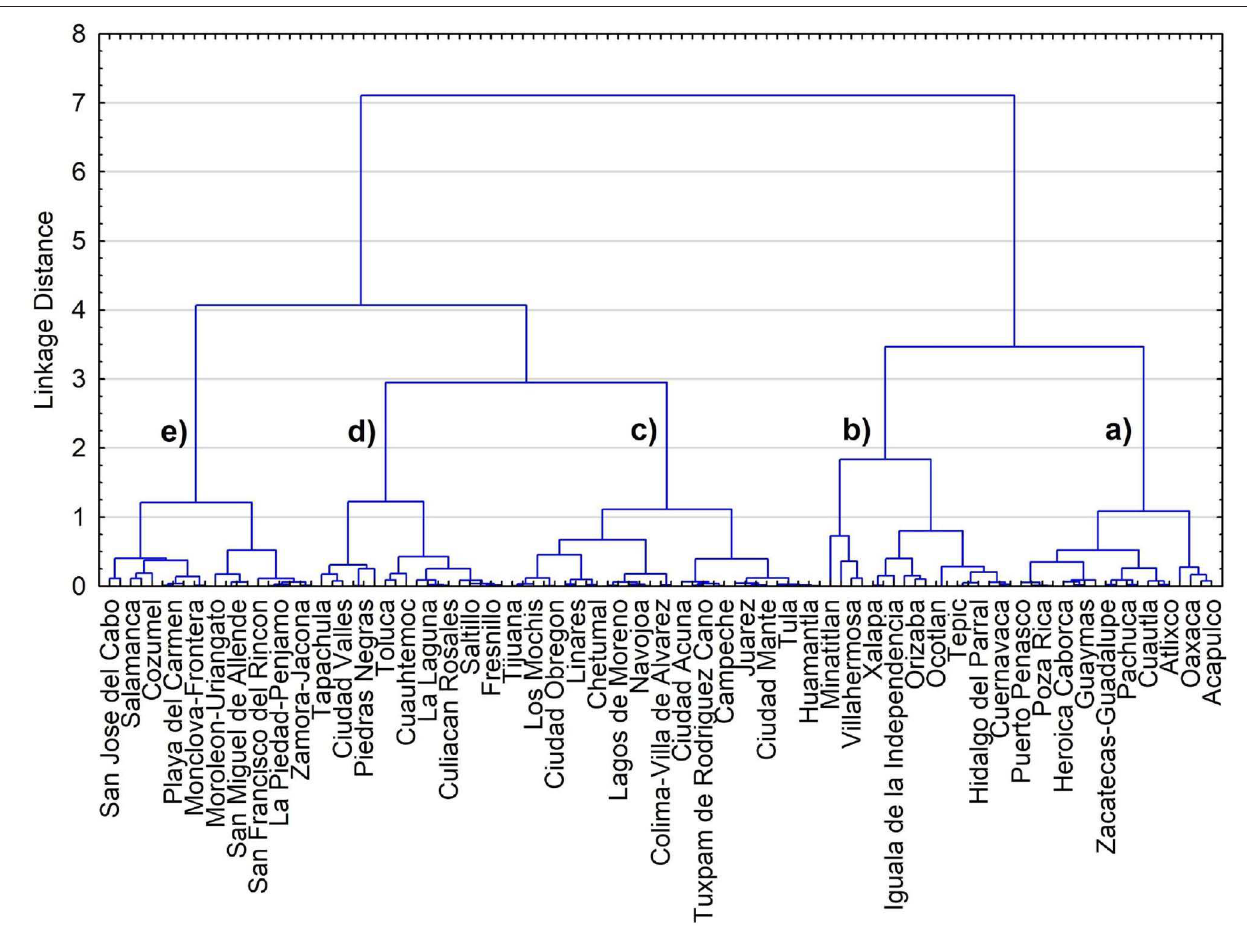
FIGURE 7 | Cluster analysis of cities based on their score in the composite sustainability index and in their climatic departures in 2050 under the RCP8.5 scenario. Ward’s amalgamation method and Euclidean distances were